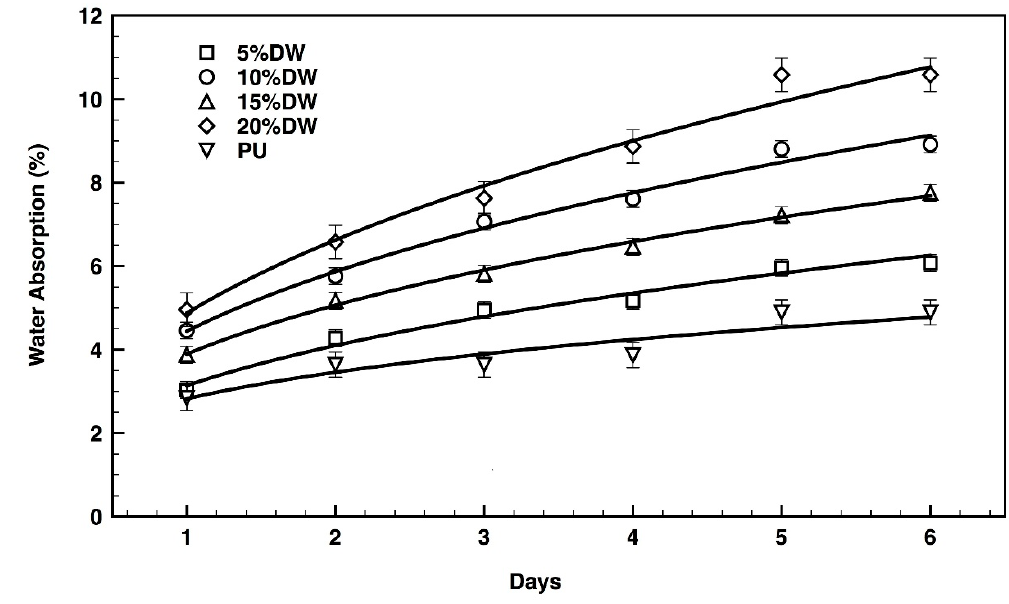
Figure 9. Water adsorption capacity of the pristine PU and the dog wool-reinforced eco-composites over time.